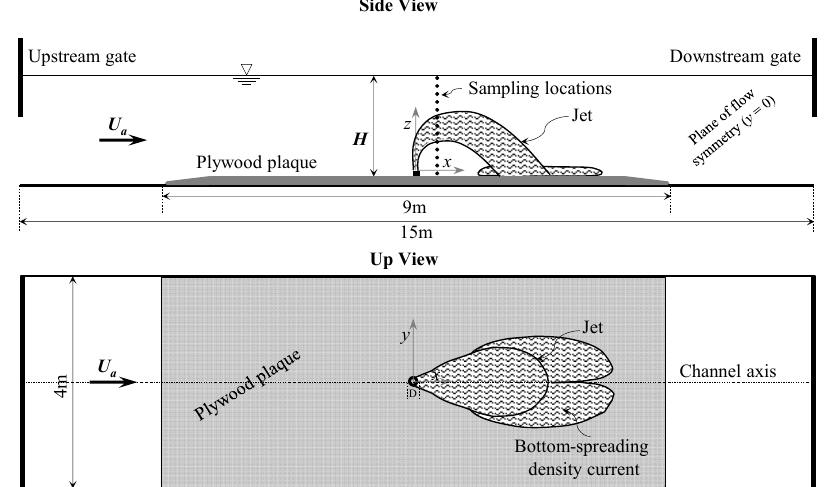
Figure 3. General sketch of the laboratory flume with the jet flow. For the sake of simplicity, only one vertical profile is qualitatively presented to show the sampling locations, the same sampling locations are repeated at different downstream locations x / D along the plane of flow symmetry.